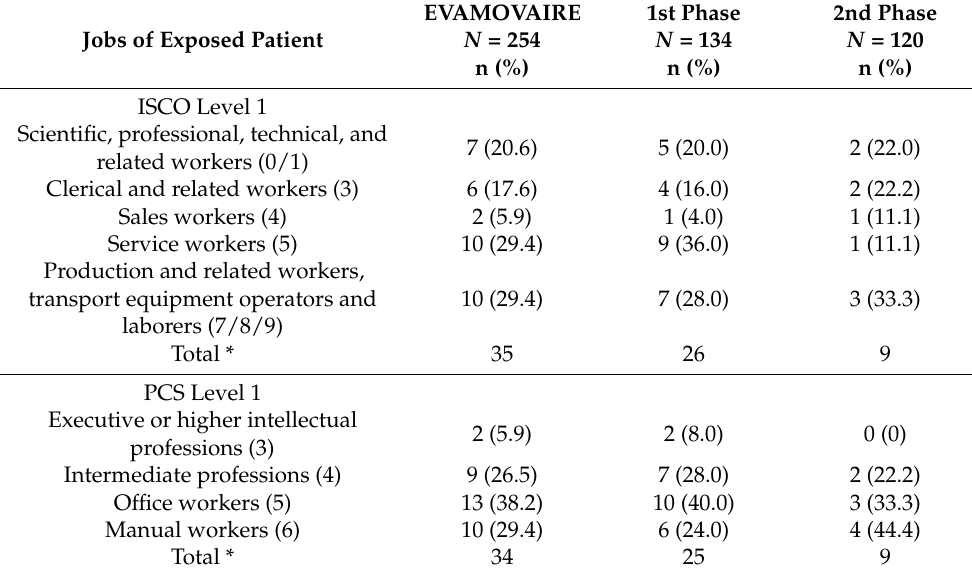
Table 4. Jobs of exposed patients by ISCO, PCS, and NAF.